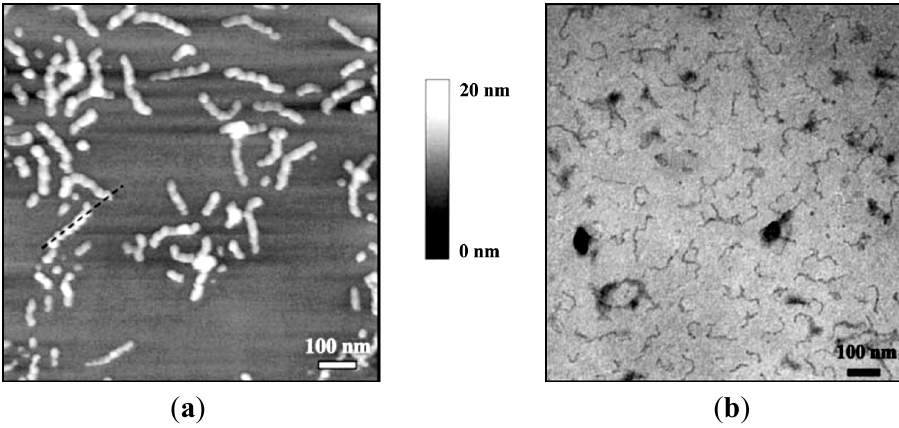
Figure 22. ( a ) AFM height image of the polychelate of Brush 1 and FeCl and ( b ) TEM image of uni-molecular polymer brush polychelate of FeCl Adapted with permission from [44]. Copyright 2004 Springer-Verlag.